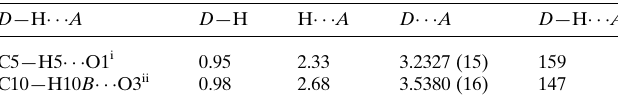
Table 1 Hydrogen-bond geometry (A˚ , (cid:3) ).